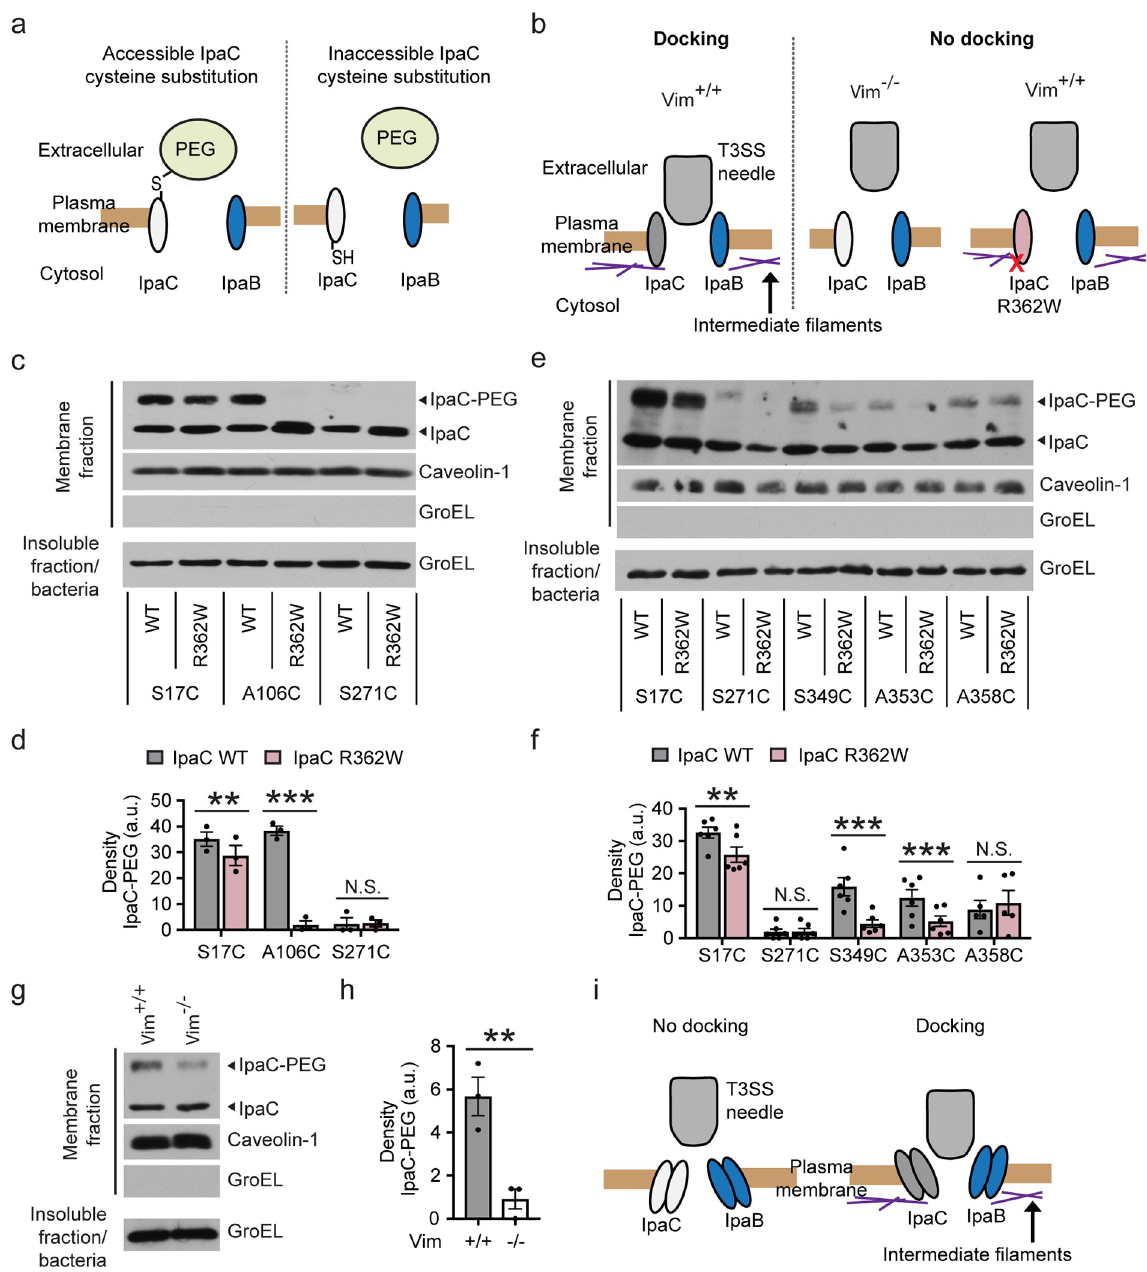
Fig 3. Accessibility of IpaC residues from the extracellular surface is altered by the interaction of IpaC with intermediate filaments. (a) Schematic of PEG5000-maleimide labeling of IpaC residues accessible from the extracellular face of the plasma membrane. PEG, PEG5000-maleimide. (b) Schematic of docking phenotype for translocon pores formed by WT IpaC or IpaC R362W, a derivative of IpaC unable to interact with intermediate filaments. (c-f) PEG5000-maleimide labeling of sulfhydryl groups in cysteine substitution derivatives in the context of WT IpaC or IpaC R362W during S . flexneri infection of HeLa cells. PEG5000-maleimide labeling of residue A106C in the transmembrane span ( c-d ) and residues S349C and A358C near the C terminus ( e-f ). Representative western blot of IpaC in plasma membrane- enriched fractions following PEG5000-maleimide labeling during infection ( c and e ). Densitometry analysis of bands corresponding to IpaC-PEG5000 ( d and f ). IpaC-PEG5000, IpaC derivatives labeled with PEG5000-maleimide; IpaC, unlabeled IpaC derivatives. (g-h) Decreased accessibility of IpaC A106C during infection of cells lacking intermediate filaments (Vim -/- ) as compared with cells containing intermediate filaments (Vim +/+ ). Representative western blot of IpaC in plasma membrane-enriched fractions following PEG5000-maleimide labeling during infection with S . flexneri producing IpaC A106C ( g ). Caveolin-1, marker of eukaryotic plasma membrane; GroEL, bacterial cytosolic protein. Densitometry analysis of IpaC-PEG5000 bands ( h ). (i) Model of the dependence of docking of the T3SS on conformational changes in the translocon pore induced by the interaction of IpaC with intermediate filaments. Graphed data are presented as mean ± SEM of three